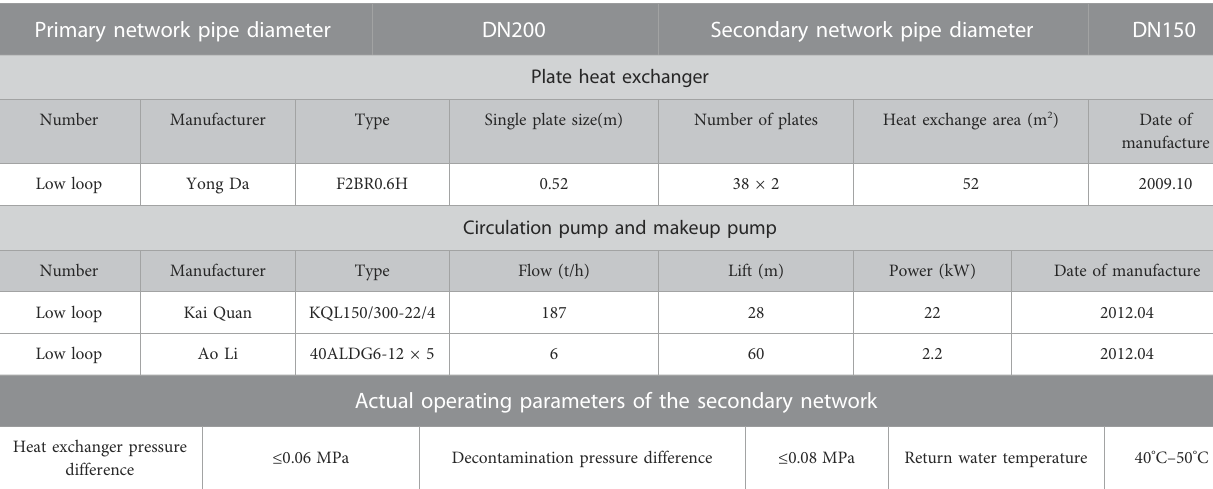
TABLE 3 Heating substation equipment details and operating